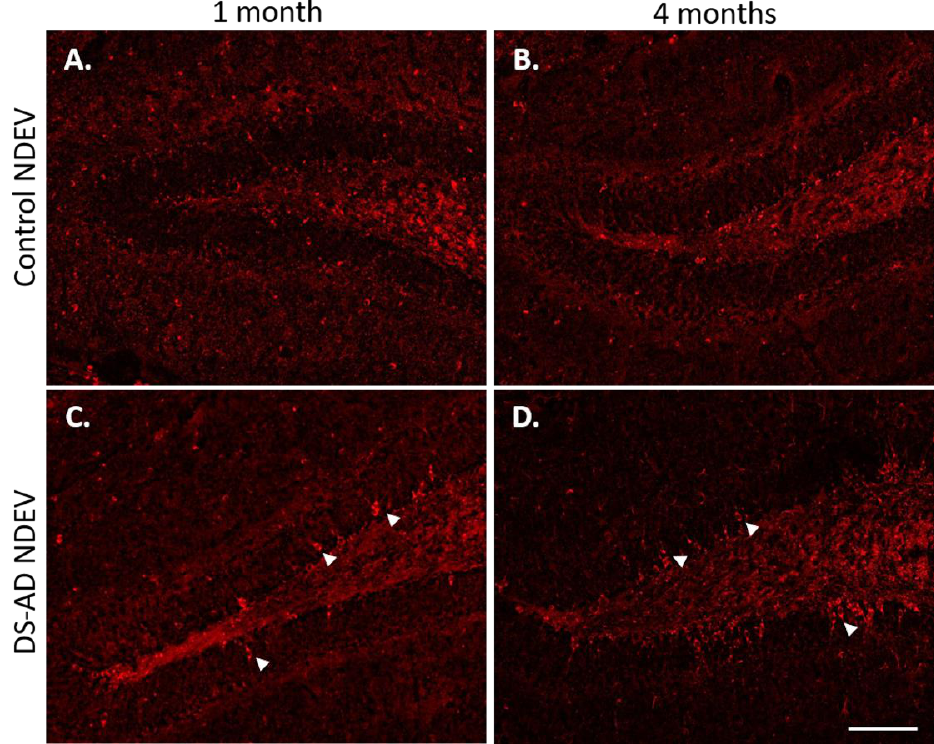
Figure 4. Representative images of p-Tau (S396) staining in WT mouse dentate gyrus area 1 month or 4 months following intra-hippocampal injections of NDEVs enriched from plasma from a control case ( A , B ) and a DS-AD case ( C , D ). Note the significant increase in p-Tau inclusions in neurons after DS-AD NDEV injections (arrowheads in ( C , D )), especially in neurons located in the granule cell layer (GCL). Few, if any, intraneuronal p-Tau inclusions were observed in brains injected with control NDEVs ( A , B ). Scale bar in ( D ) represents 100 µ